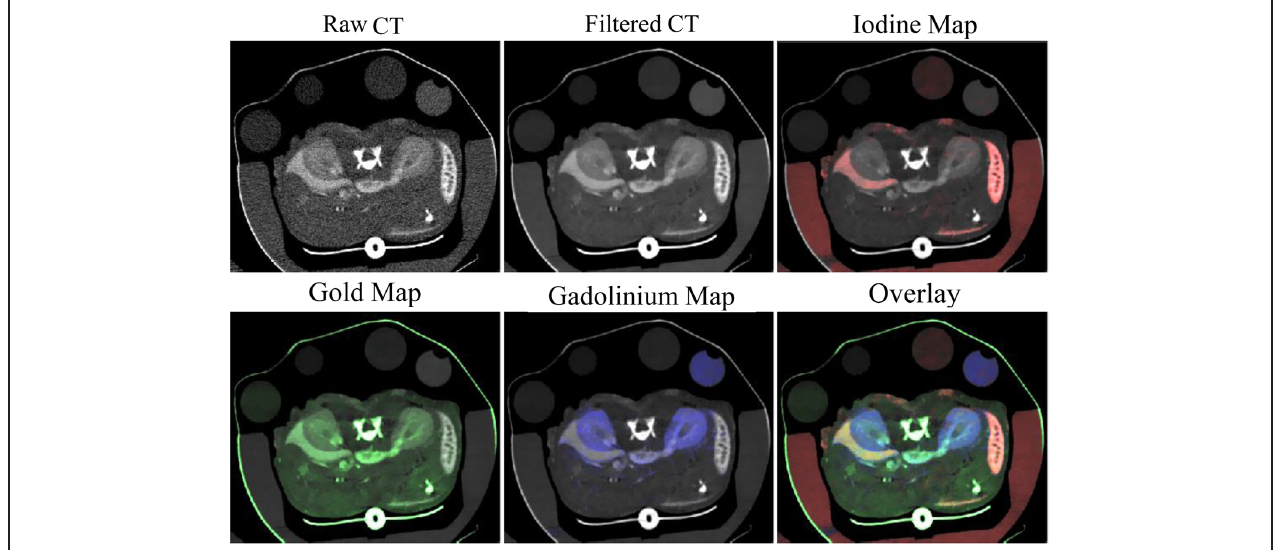
FIGURE 14 | Three-energy micro-CT imaging in a mouse. Liposomal iodine was injected 72 h before imaging. Gold nanoparticles and low molecular weight gadolinium were injected immediately before imaging. Images were acquired at three energies, filtered, then separated into maps of iodine (red), gold (green), and gadolinium (blue)